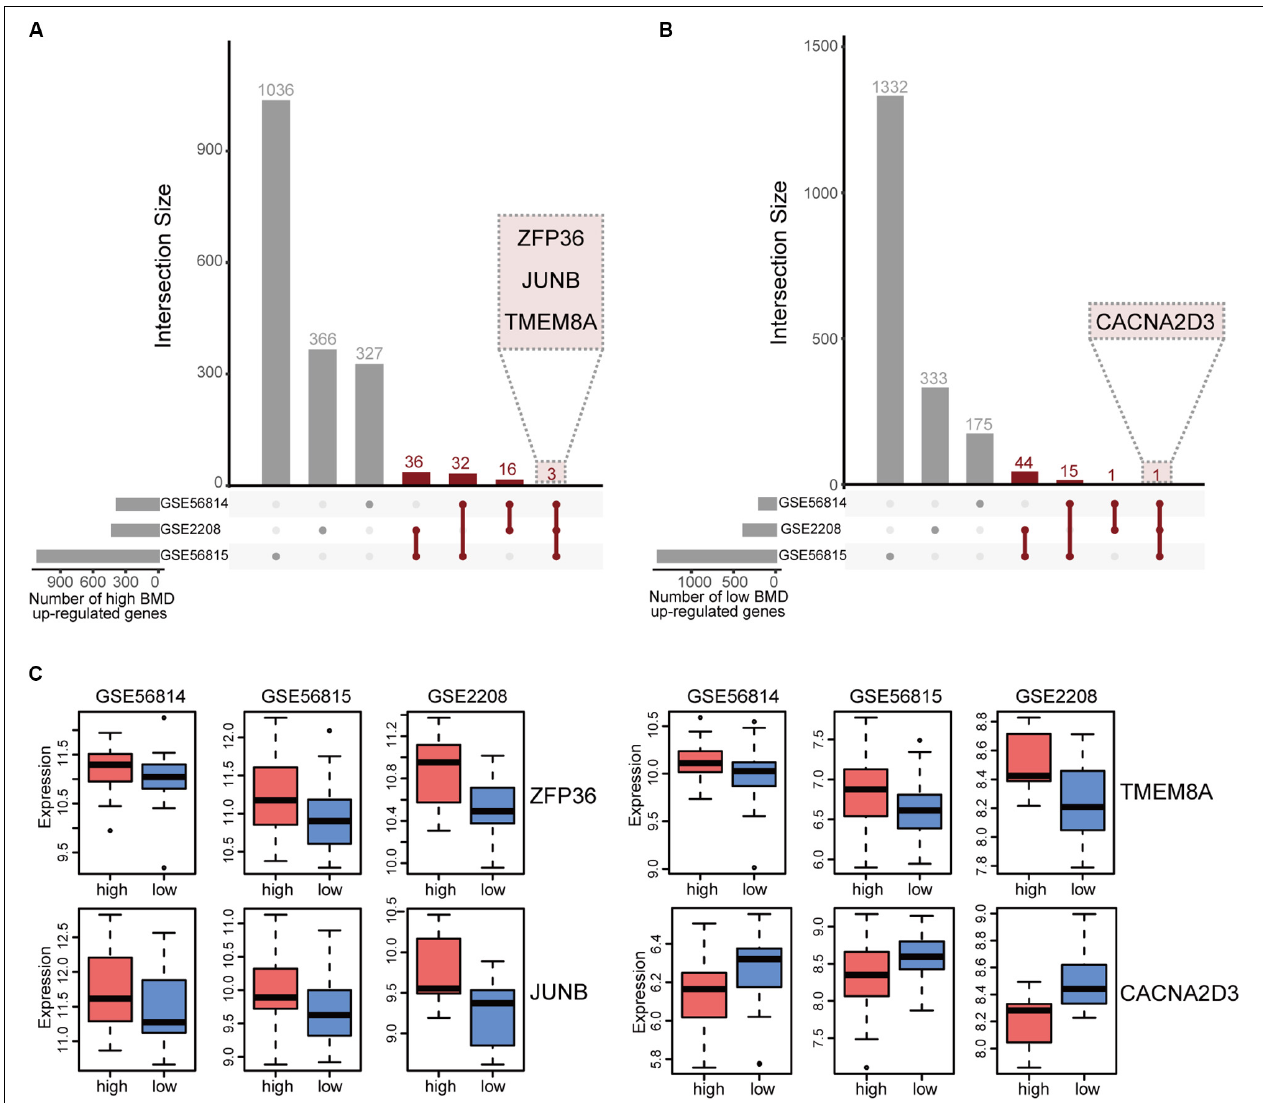
FIGURE 2 | Integration of BMD-related DEGs. (A) UpSetR plot of genes up-regulated in high BMD samples, the number of genes present in at least two datasets is marked (red). (B) UpSetR plot of genes up-regulated in low BMD samples, the number of genes present in at least two datasets is marked (red). (C) Boxplot of genes that expressed consistently across all three datasets.